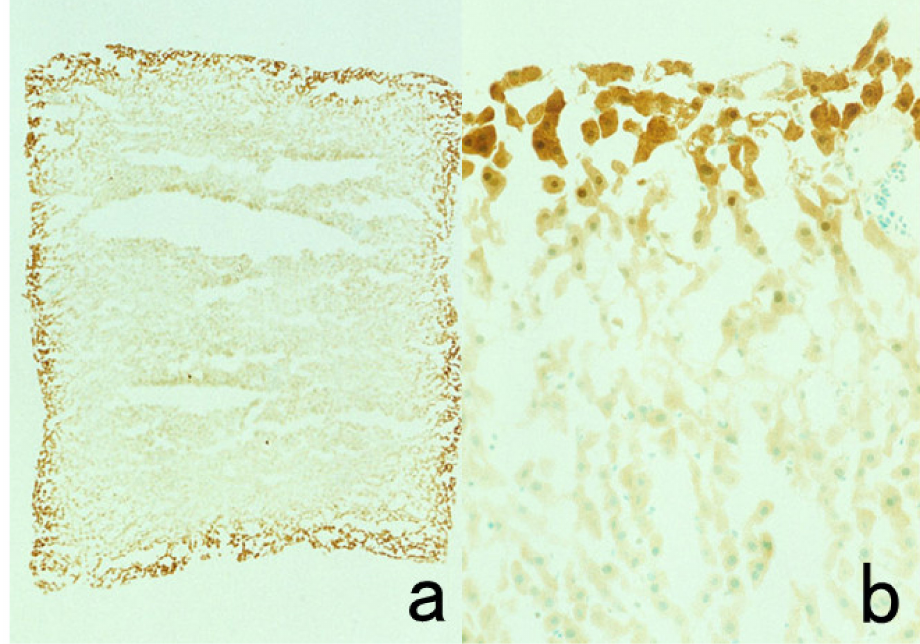
Figure 15. Glutathione peroxidase immunostaining using a frozen section prepared from 4% paraformaldehyde-fixed rat liver tissue ( a ): low power, ( b ): high power. Positive immunoreactiv- ity in the cytoplasm and nucleus of the hepatocytes is seen just at the outermost part of the